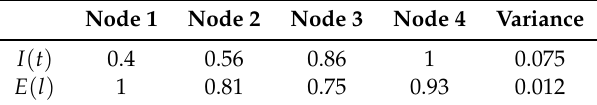
Table 1. Parameters with diferent variances.